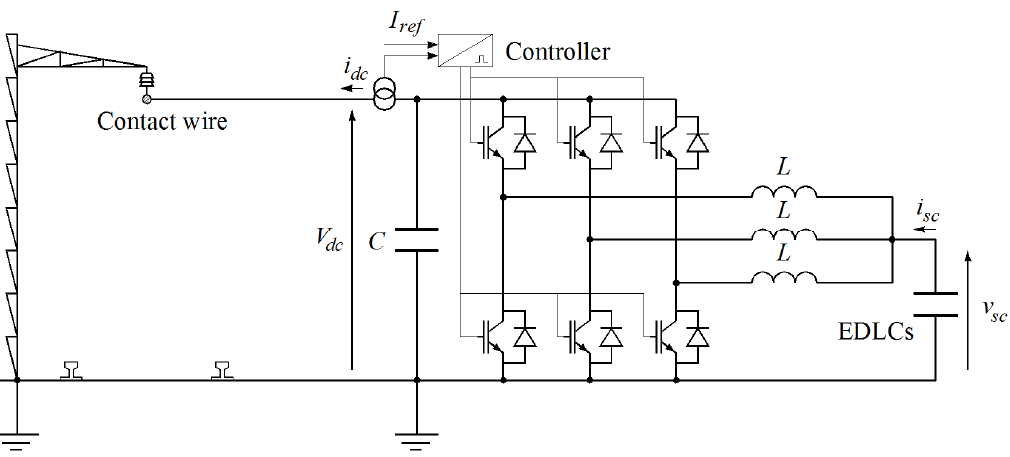
Figure 3. Connection of EDLCs to the contact